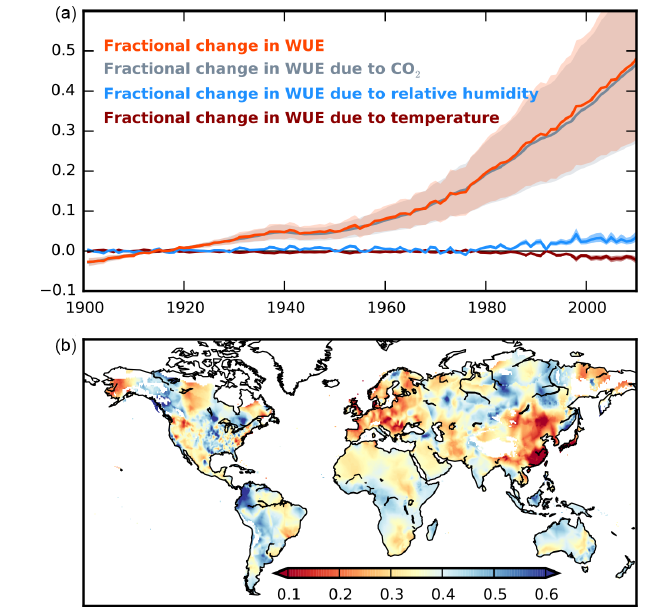
Figure 5. 20th century fractional change of water-use efficiency (WUE). (a) Time series of the estimated global fractional change in WUE (orange, relative to the average over 1901–1930) parti- tioned into the effects of changes in CO 2 , relative humidity and temperature. (b) Spatial pattern of the estimated fractional change in WUE between 1901–1930 and 2001–2010. These calculations use observed monthly surface air temperature and vapour pressure (Harris et al., 2013) during the growing season, and annual atmo- spheric CO 2 concentrations at Mauna Loa (Keeling et al., 1976).